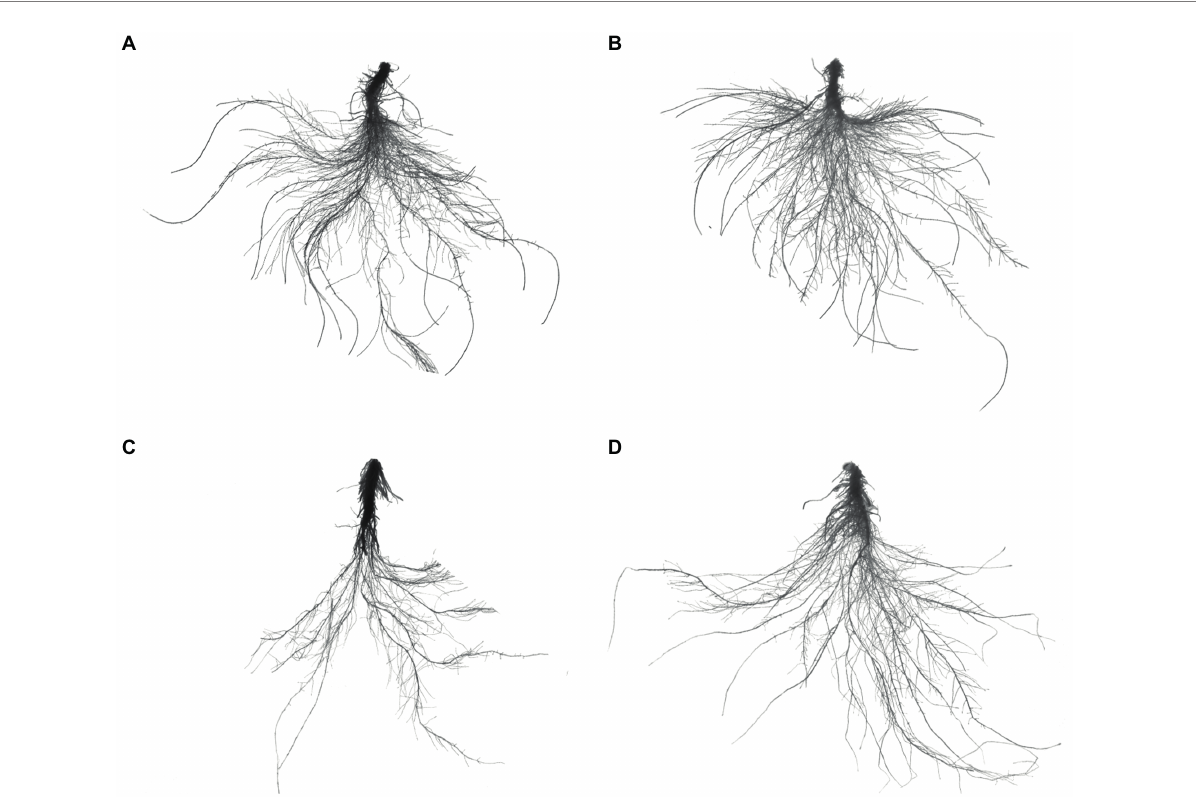
FIGURE 5 Effect of exogenous Si on the root morphology of cucumber seedlings under cinnamic acid (CA)-induced autotoxicity stress. (A) CK: normal nutrient solution; (B) 1 mmol L − 1 Si; (C) 0.8 mmol L − 1 CA; and (D) 0.8 mmol L − 1 CA + 1 mmol L − 1 Si.